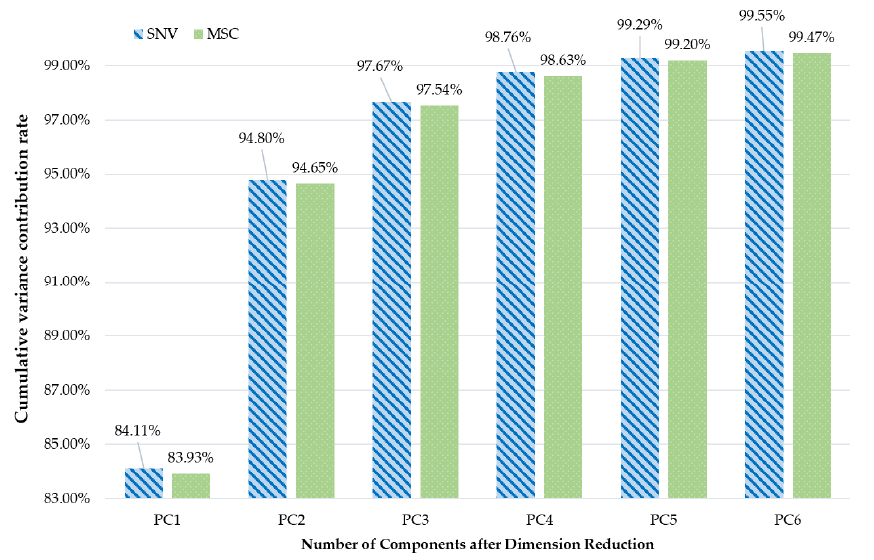
Figure 9. Principal component cumulative contribution after SNV and MSC.